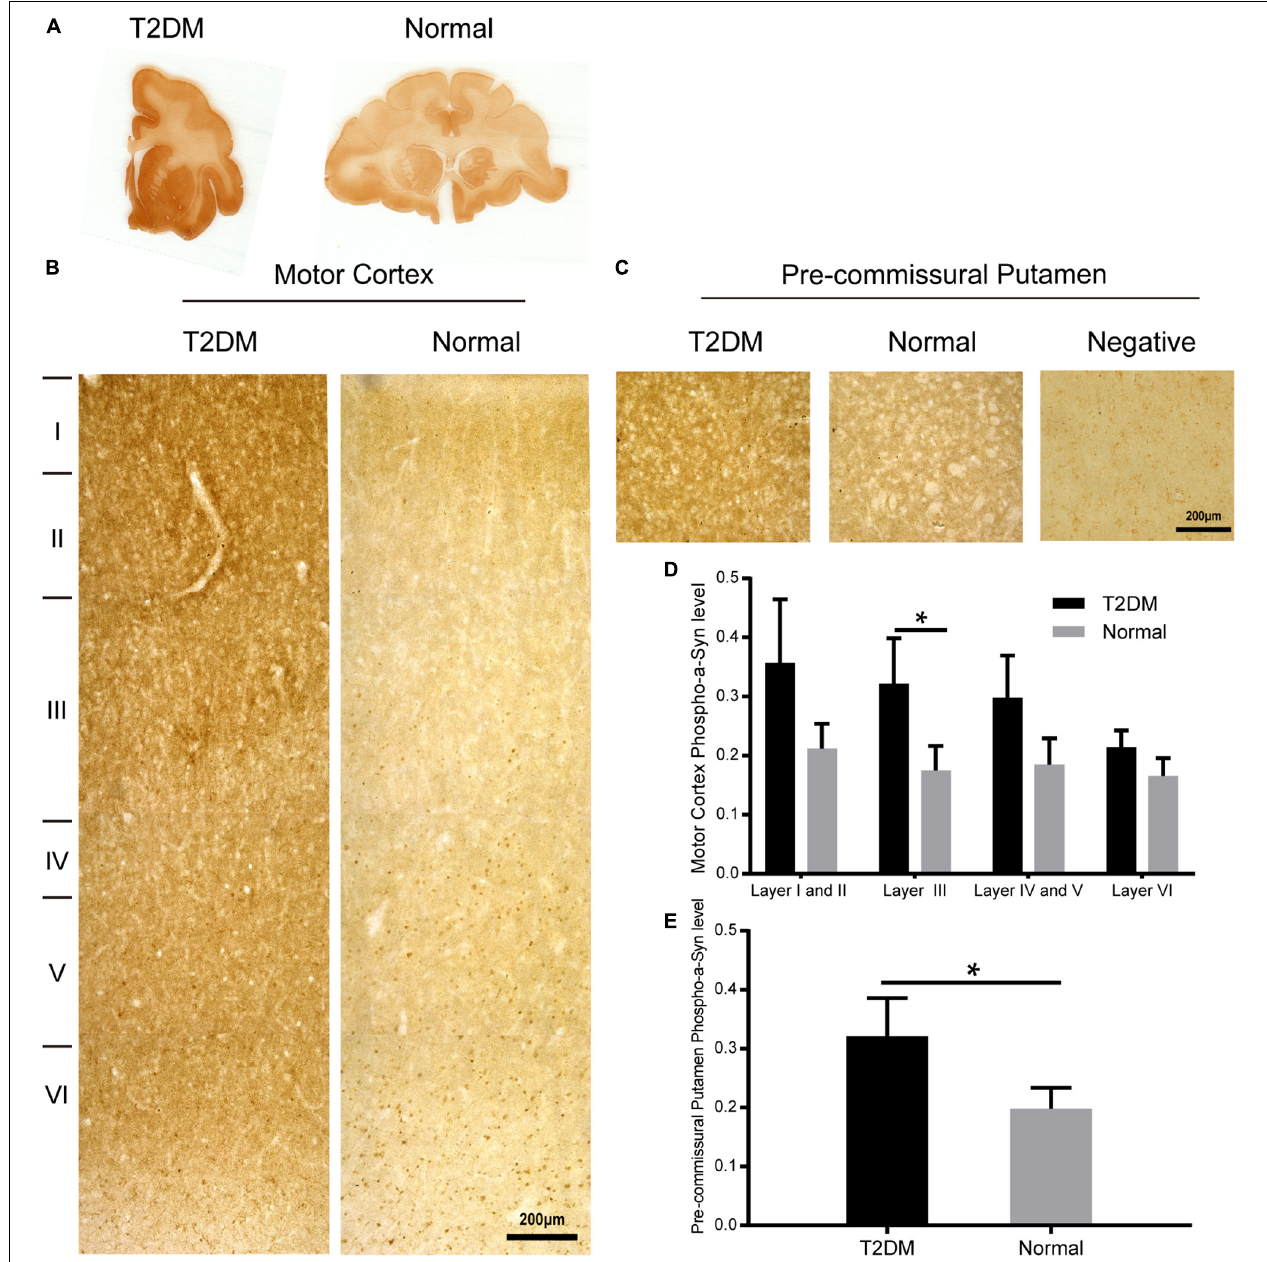
FIGURE 7 | Phosphorylated α -synuclein in the motor cortex and the pre-commissural putamen of diabetic and normal monkeys. Immunohistochemistry for phosphorylated pS129 α -synuclein in the motor cortex marked with estimated cortical layers (B) and in the pre-commissural putamen (C) of a T2DM monkey (left) and an age-matched normal monkey (right). Macro-scanned images of the immunohistochemically stained sections (A) . A negative control image without the primary antibody incubation was also shown (right, in C ). High power images were also shown in Supplementary Figure S3 . Scale bars = 200 µ m in (B,C) . Quantitative analysis of immunohistochemical intensity of phosphorylated α -synuclein (D,E) in the motor cortex (D) and in the pre-commissural putamen (E) . Data is represented with the mean ± SE ( n = 5 ∼ 7), * p <